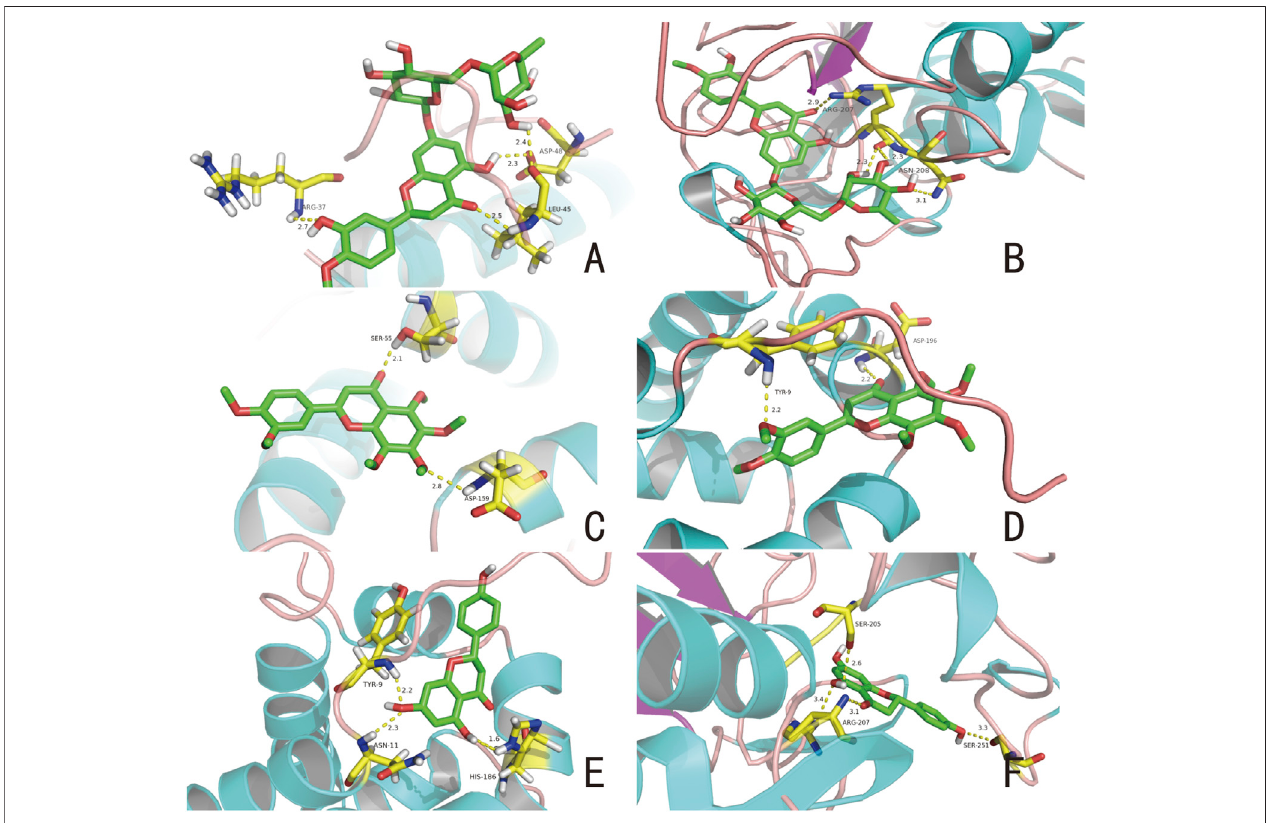
FIGURE 4 | Selected compounds ’ interactions with the targets. (A) Hesperidin with BAX, (B) hesperidin with CASP3, (C) nobiletin with BAX, (D) nobiletin with BCL2, (E) naringenin with BCL2, (F) naringenin with CASP3. The molecule is represented in a ball-stick model with atoms C, O, and N in green, red, and blue, respectively. Dashed lines indicate hydrogen bonds, and the numbers above represent distances in angstroms